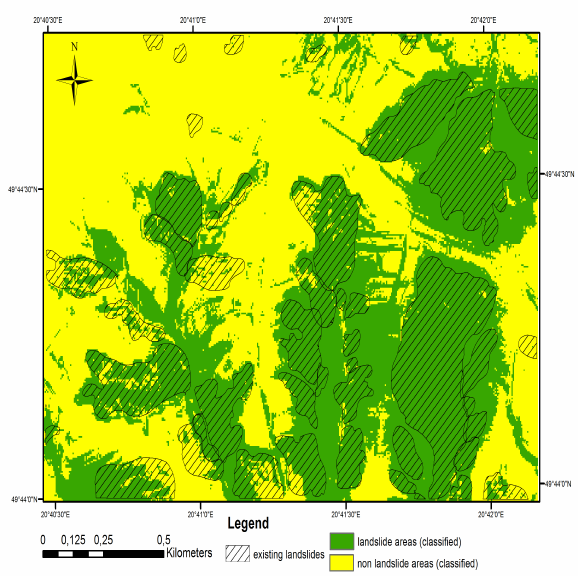
Figure 7: SVM classification results (green areas) for all DEM- derivtives and the existing landslides (hatched polygons)